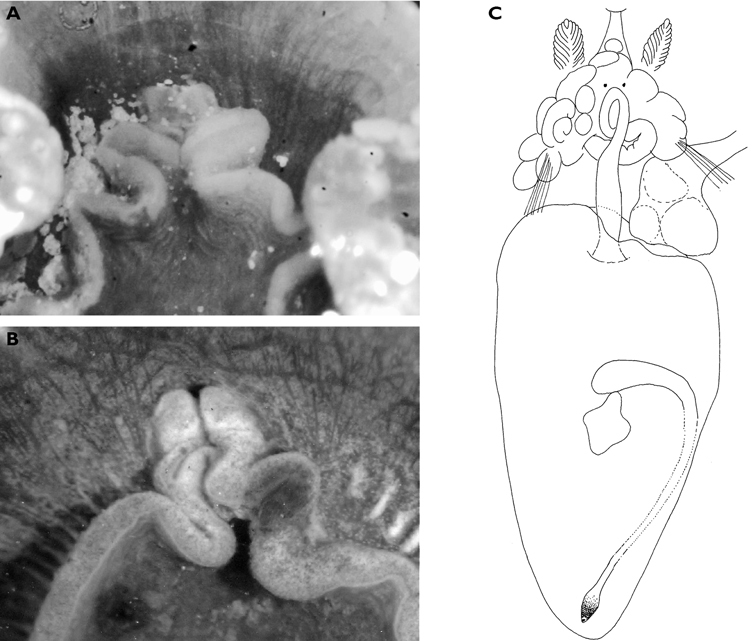
Phyllidia multituberculata
A ventral view showing propodium, head, and oral tentacles, 30 mm pres. Socotra specimen B ventral view showing head and oral tentacles, 28 mm pres. Maldives specimen C anatomy of 28 mm pres. Maldives specimen.